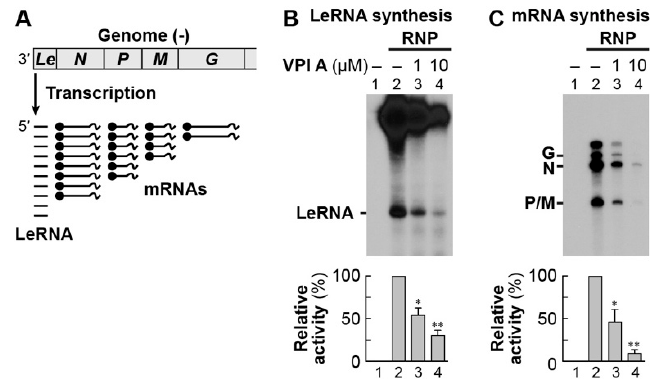
lanes 1 and 2, no drug) were set to 0 and 100%, respectively. Symbols and error bars represent the means and standard deviations, respectively, of three independent experiments.